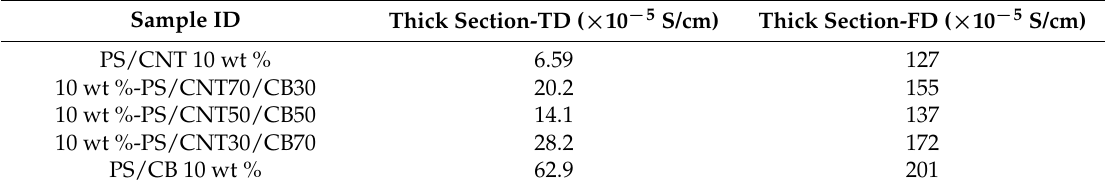
Table 3. The average σ for the thick section of 10 wt % carbon fillers loaded PS microparts.